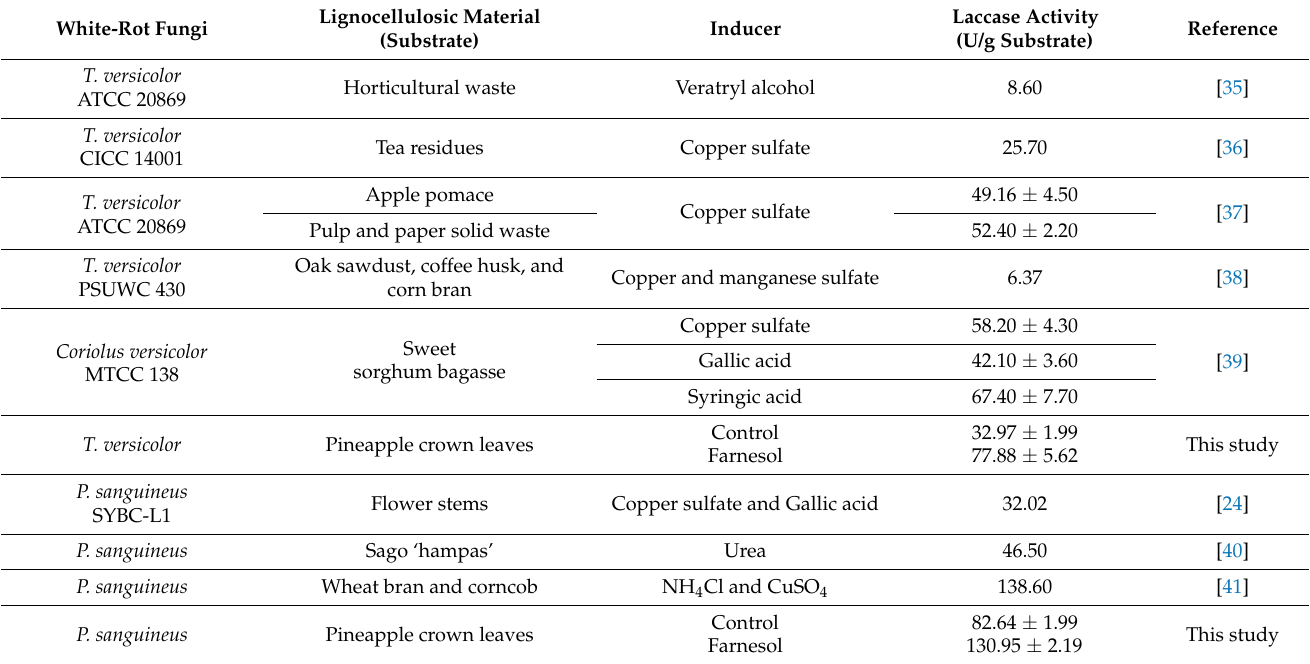
Table 3. Laccase production (U/g) by T. versicolor and P. sanguineus in SSF with or without